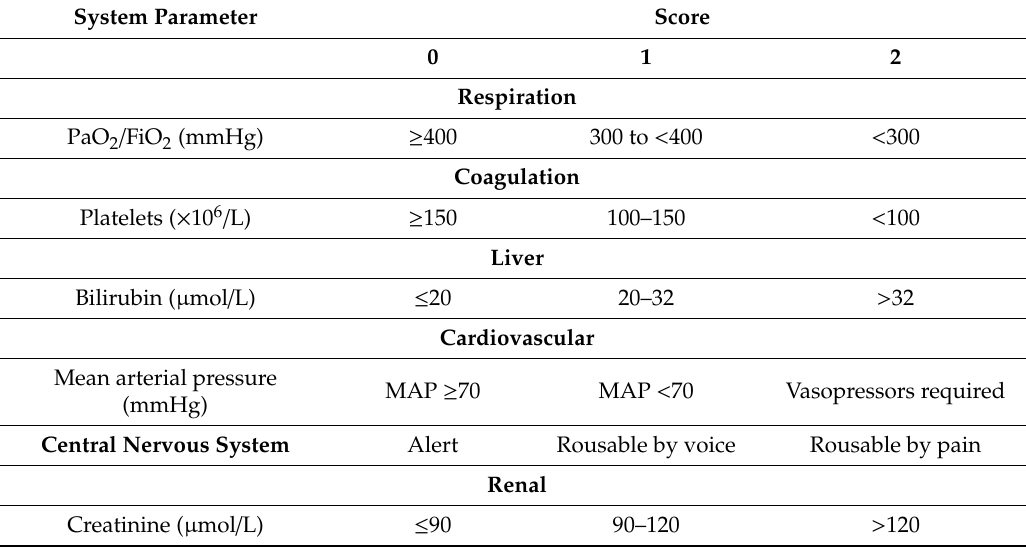
Table 2. Obstetrically modified SOFA